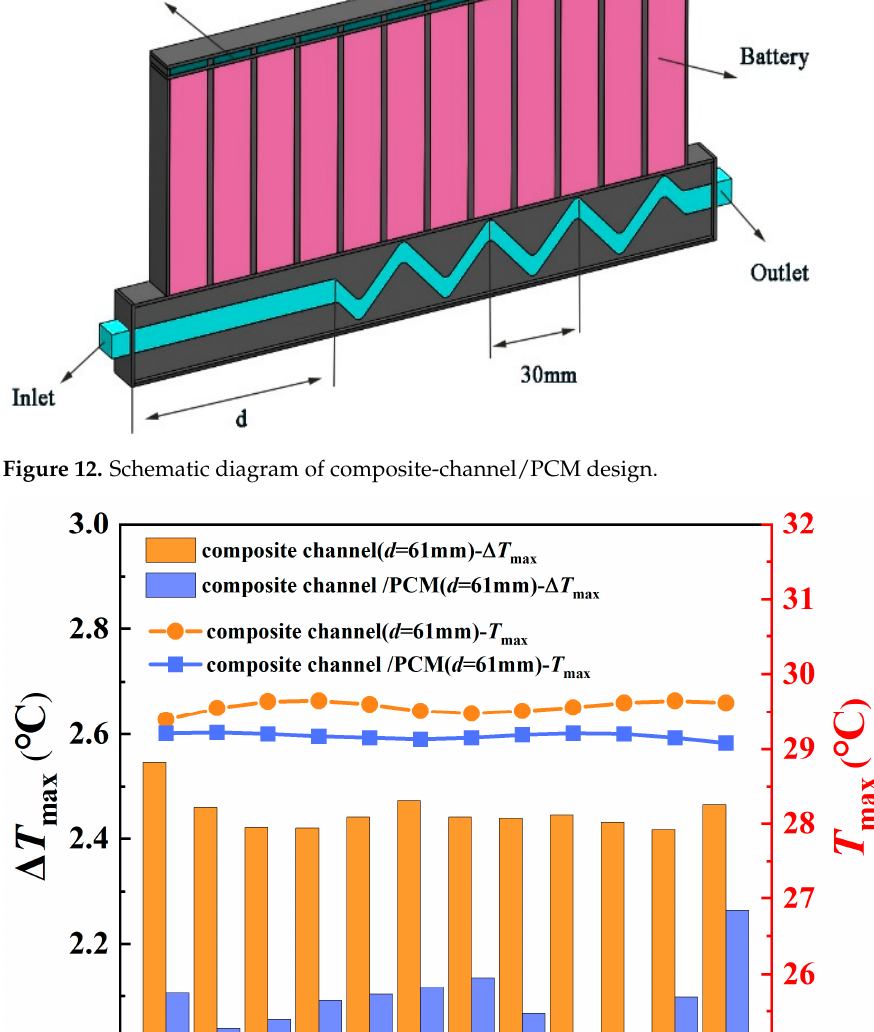
Figure 13. Temperature of composite-channel/PCM design.